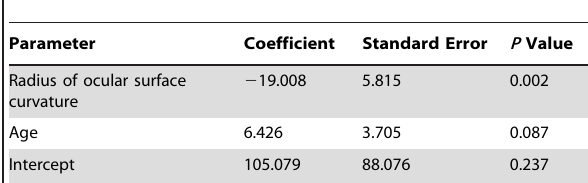
Table 5. Results of the multiple linear regression analysis with the stepwise method in which the average ocular surface displacement at the time of IOP reading was the outcome